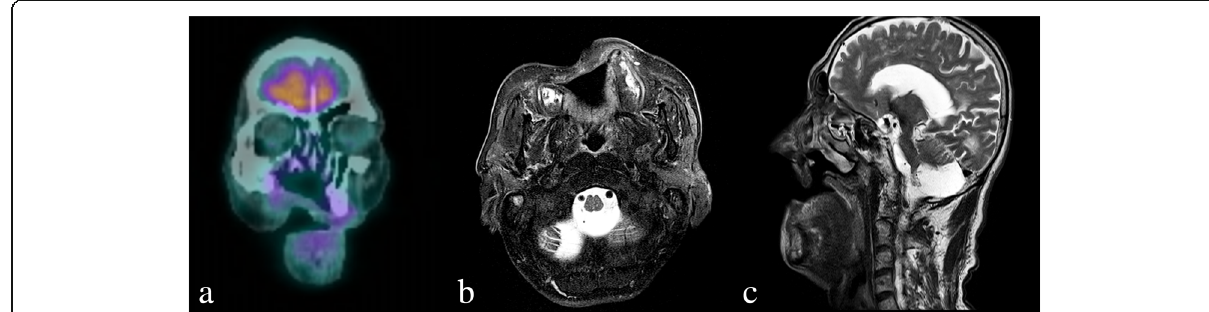
Fig. 6 PET and MRI scans acquired 6 months after surgery indicate no recurrence of findings. a 18-FDG PET/CT coronal view showing only slight spots around the partial maxillectomy area due to the surgery. b T2-weighted MRI scan, axial view. c T2-weighted MRI scan, sagittal view